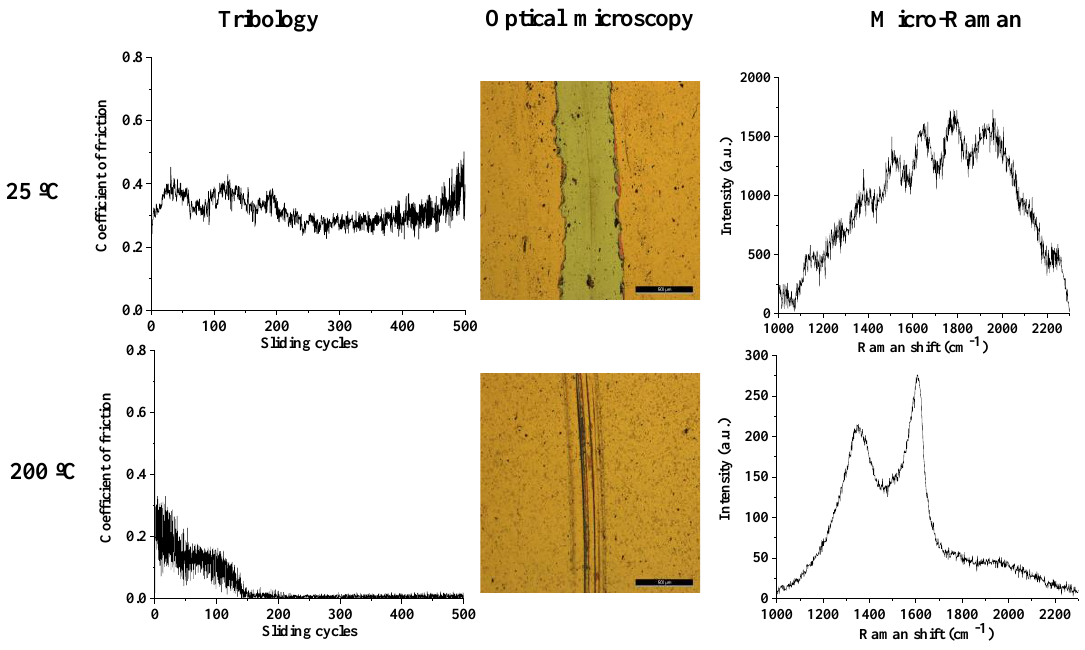
Figure 8. Coefficient of friction, optical macrographs, and micro-Raman characterization of the wear tracks of Cu-C60 after 500 sliding cycles, with 2 N load, at different temperatures (bar = 500 μm).